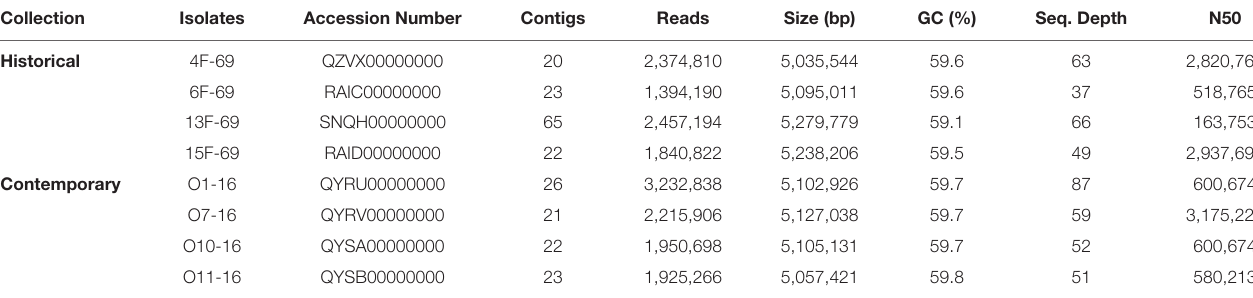
TABLE 2 | Sequencing information of the eight Serratia marcescens bacterial genomes compared in the study from Nullarbor pipeline report. Collection Isolates Contigs